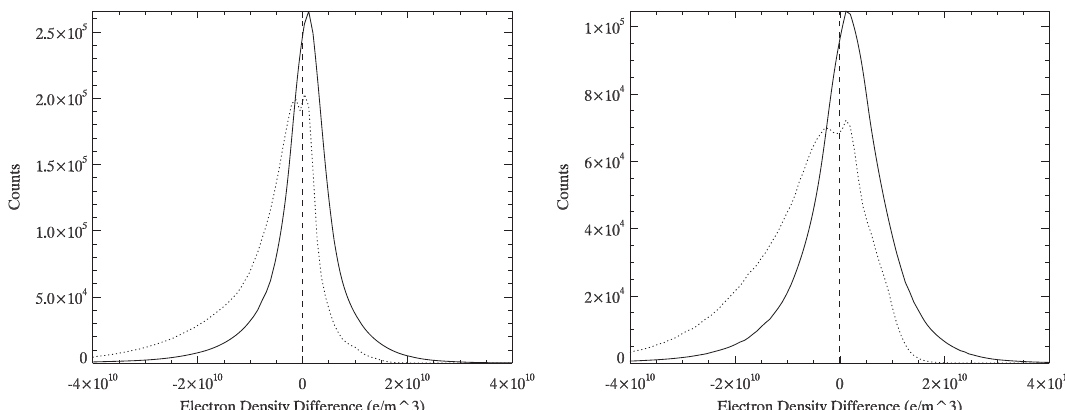
Fig. 3. Probability distributions of electron density errors for the IRI (dotted lines) and E-CHAIM (solid lines) with respect to DMSP in situ electron density data for satellite F17 (left) and satellite F18 (right).